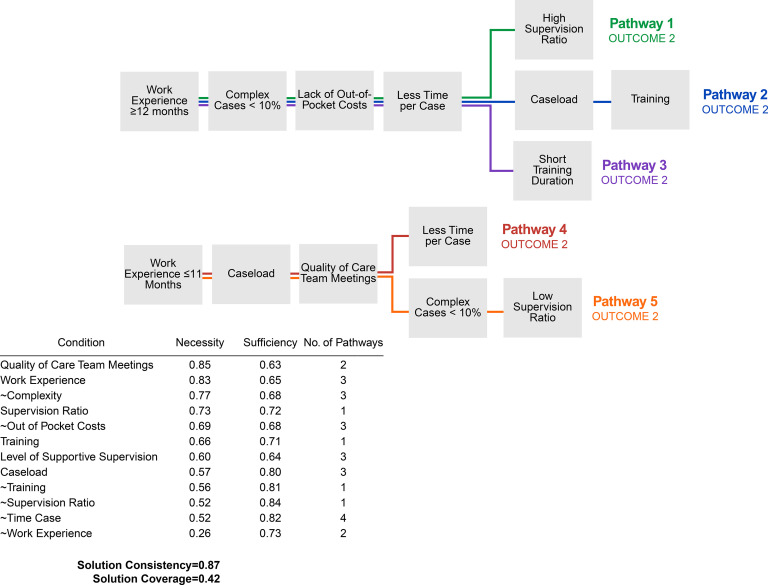
Outcome 2: Percentage of Orphans or Vulnerable Children in Mozambique With HIV Status Known